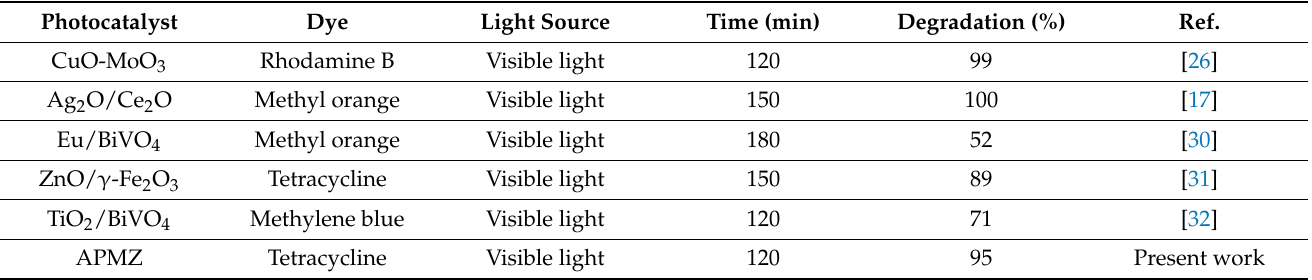
Table 2. Comparative photocatalytic study for the degradation of TC with other studies.